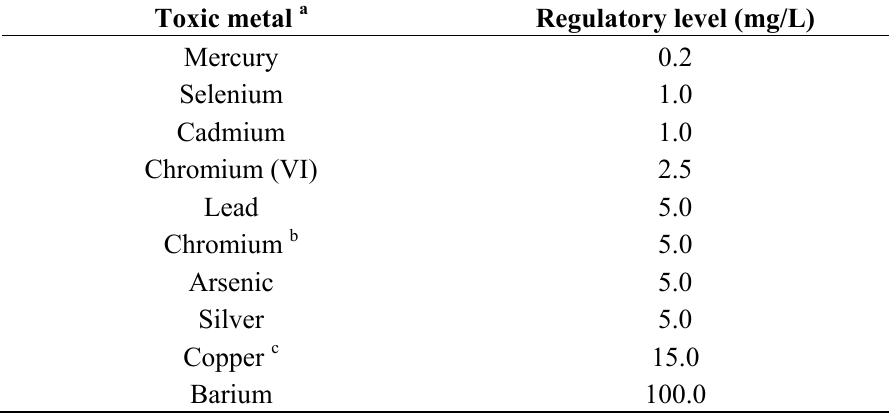
Table 1. Toxicity characteristic constituents (toxic metal) and their regulatory levels in